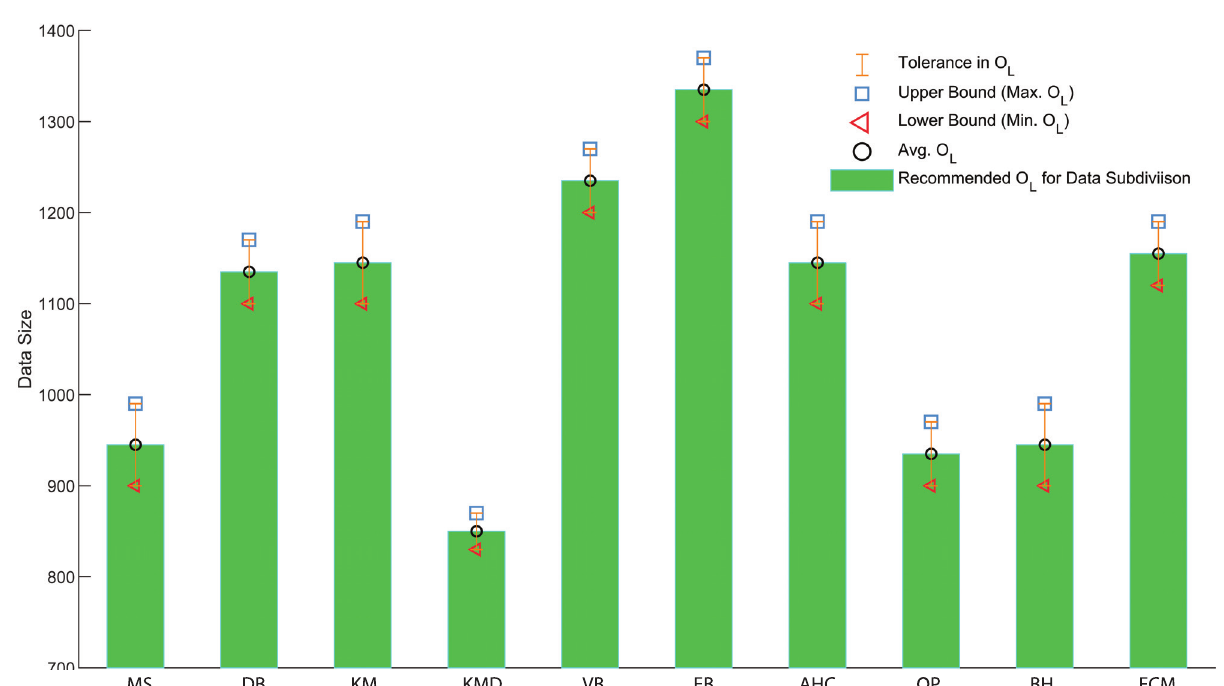
Fig 5. Identification of optimal length O . (a) Illustrates the description of steps involved in identifying the O for spike sorting algorithms. Computational time L L versus data size plot. The X-axis shows the length of the data increasing from zero to 2000 while the Y-axis shows the corresponding time taken by the clustering algorithm to perform clustering process, in milliseconds. The computational time is the processing time after movmean filter(20 datapoints length) filtered the unwanted ripples in the plot and returned smooth curves. Detected abrupt changes in the plot taking 0.1 of the maximum rate of change in computational time as threshold (d) Identified optimal length O L of data subsets used for data subdivision. b) Optimal Length ( O L ) for ten commonly used clustering algorithms. The average value over ten repetitive analyses is given as robustness of the measure in optimal length for data subdivision.